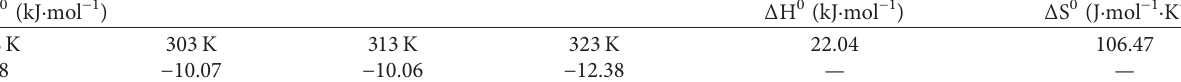
Table 3: Thermodynamic parameters of the adsorption Co 2+ ion on GO/PVA/Fe